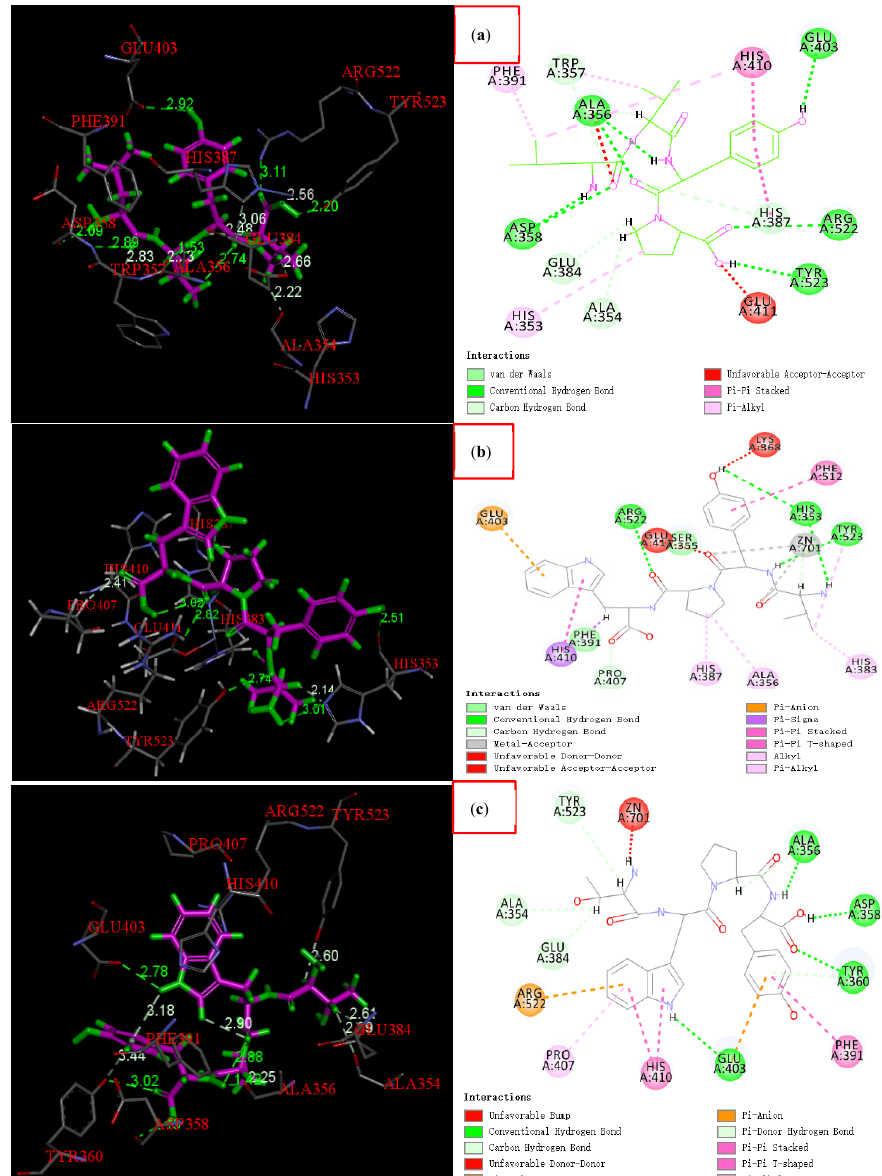
Figure 14. The docking results of three active peptide(LVYP(Leu-Val-Tyr-Pro), VYPW(Val-Tyr-Pro-Trp) and YPWT(Tyr-Pro-Trp-Thr)) molecules. The figure on the left represents the types of hydrogen bonds and their bond lengths, and the figure on the right represents all the linkages between the peptide and ACE, where ( a ) represents the combination mechanism diagram of LVYP and ACE; ( b ) represents the combination mechanism diagram of VYPW and ACE; ( c ) represents the combination mechanism diagram of YPWT and ACE.